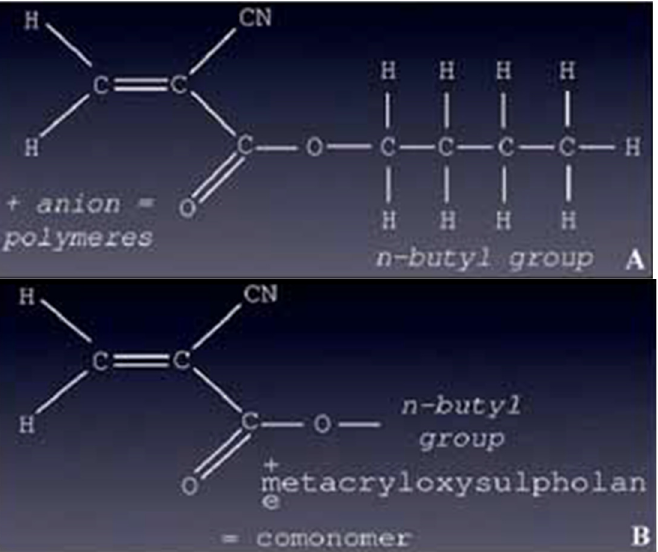
Figure 1. Chemical structure of two cyanoacrylate glues ( N -butyl cyanoacrylate). ( A ) N -butyl-2-cyanoacrylate (NBCA) (Histoacryl ® ). ( B ) N -butyl-2-cyanoacrylate (NBCA) + metacryloxysulfolane (NBCA-MS) (Glubran ® 2).